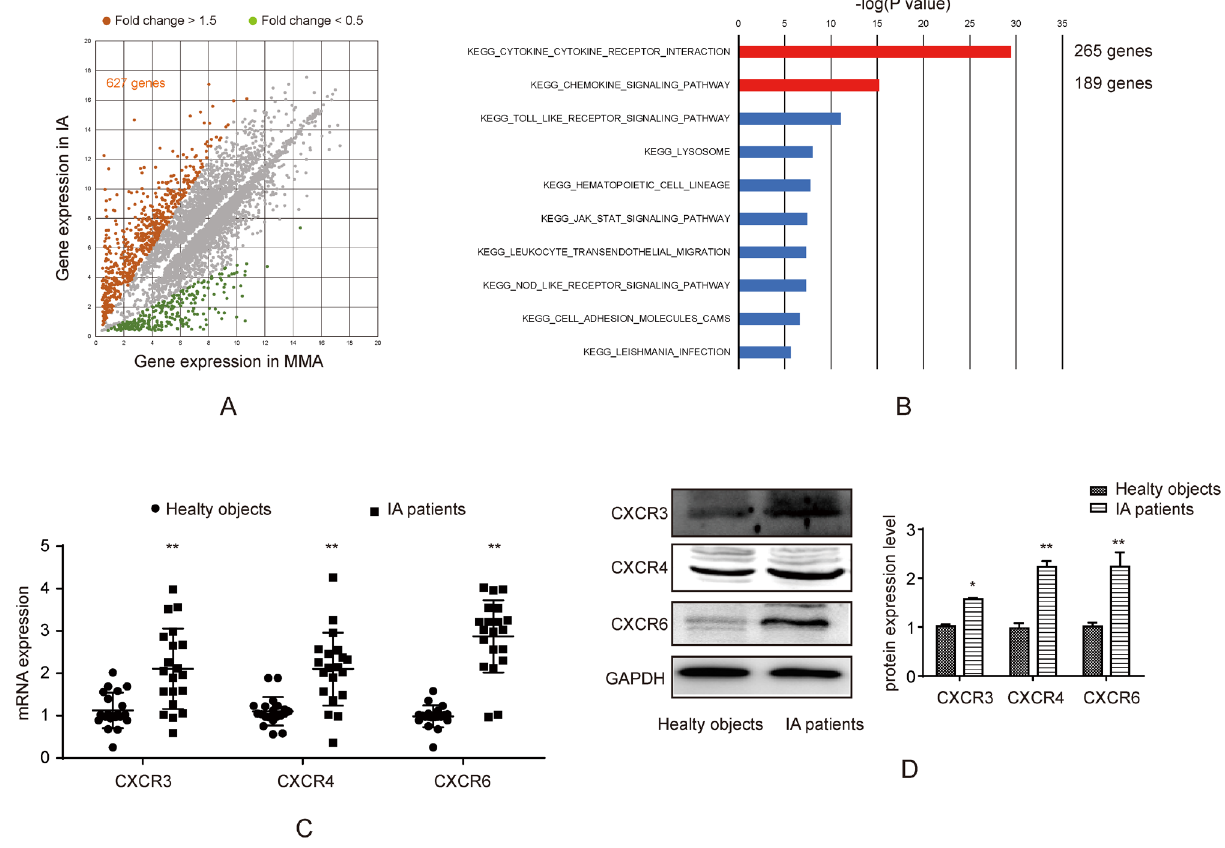
Figure 3 – CXCRs expression in IAs. (A) GEO data (GSE46338) was downloaded from GEO datasets in NCBI and analyzed, in which, x axis represents gene expression in MMA and y axis represents log gene expression in IAs. The dots of genes with fold change over 1.5 were marked brown (627 genes were found). (B) KEGG signaling analysis of 627 genes obtained from Figure 3A. (C) Real-time PCR was used to test CXCR3, CXCR4 and CXCR6 in tissues from IAs patients and healthy subjects group, **p < 0.01. (D) Western blot was used to test CXCR3, CXCR4 and CXCR6 in tissues from IAs patients and control group, quantification was calculated based on light density of bands and normalized to GAPDH, *p < 0.05, **p < 0.01 compared to healthy objects